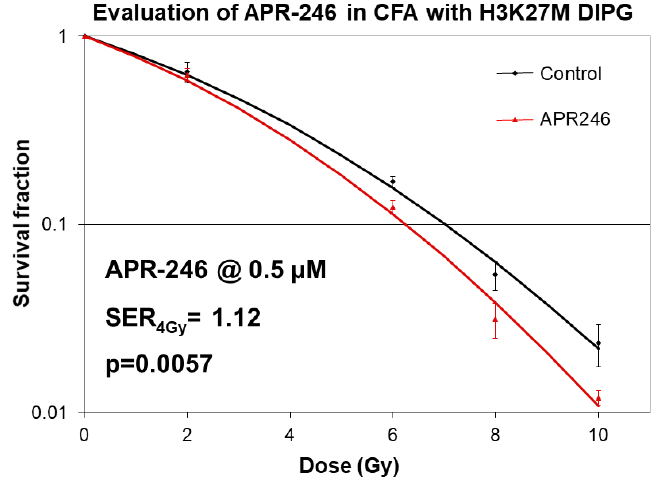
Figure 2. Radio-sensitizing effects of APR-246 in clonogenic survival assays in H3K27M DIPG cells. Clonogenic survival assays with SF8628 pediatric DIPG cell line harboring the histone H3.3 K27M mutation. DIPG cells were treated with 0.5 µM concentration of APR-246 both before and after radiation treatments (0–10 Gy doses). Survival fractions were determined 2 weeks after plating.